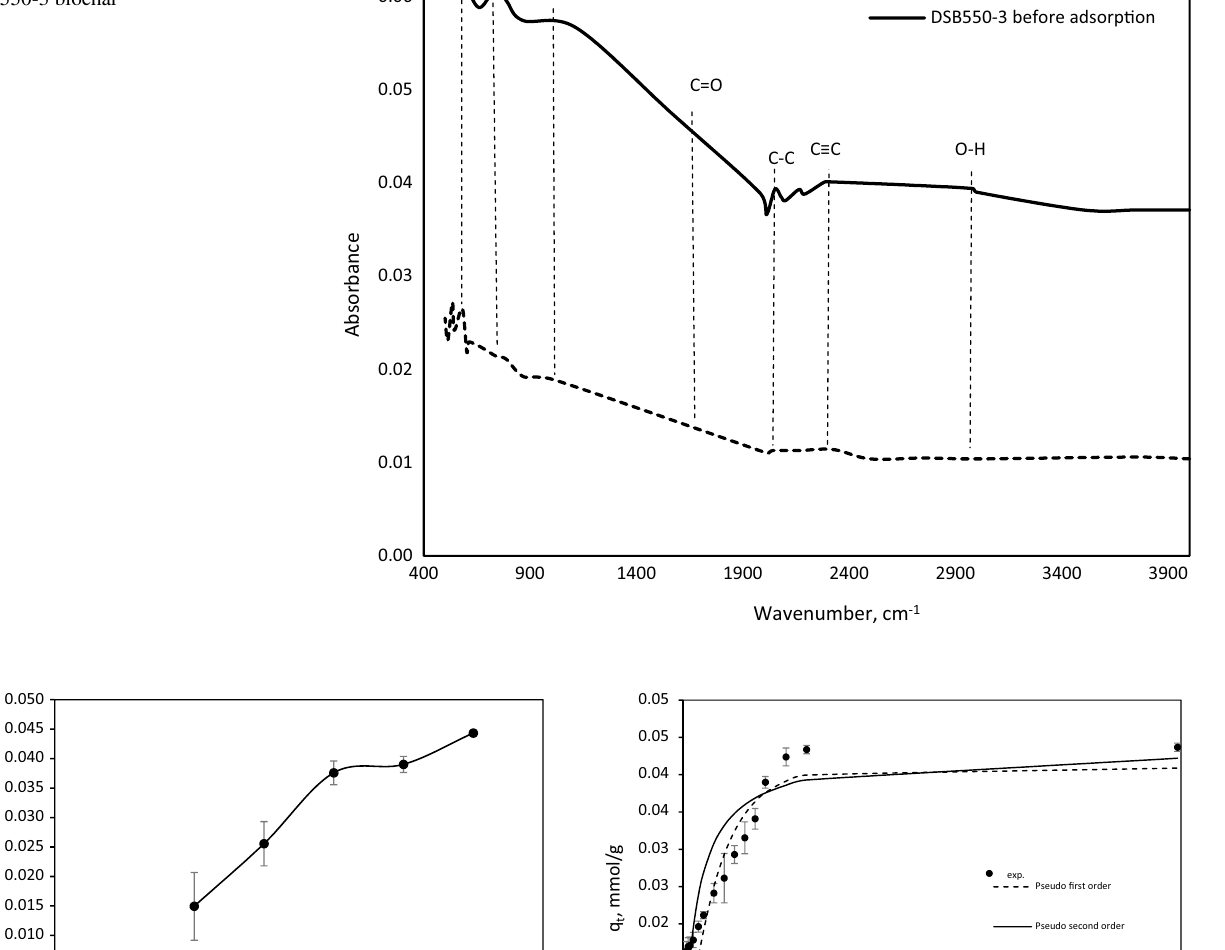
Fig. 3 FTIR spectra before and after Pb 2+ adsorption onto the